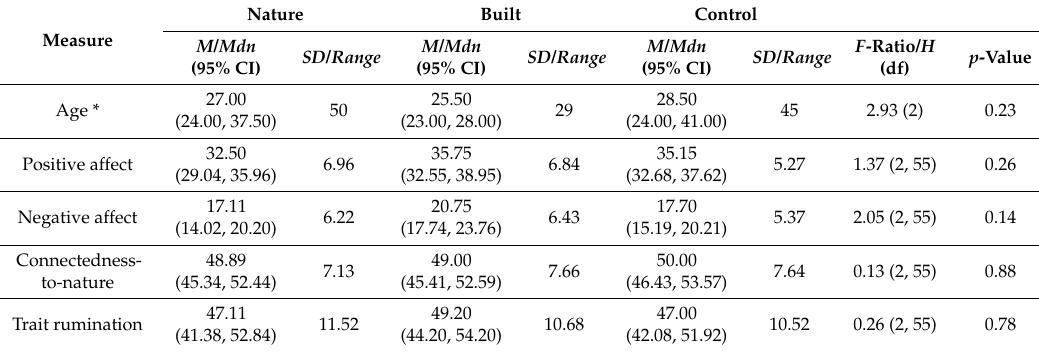
Table A1. Descriptive Statistics and Results of Tests of Differences at Baseline by Condition.